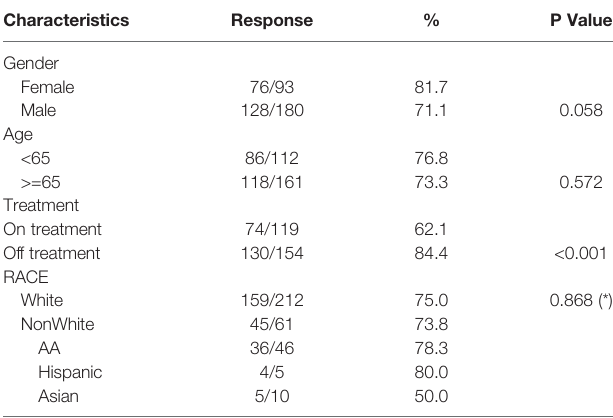
TABLE 1 | The response rates to Covid-19